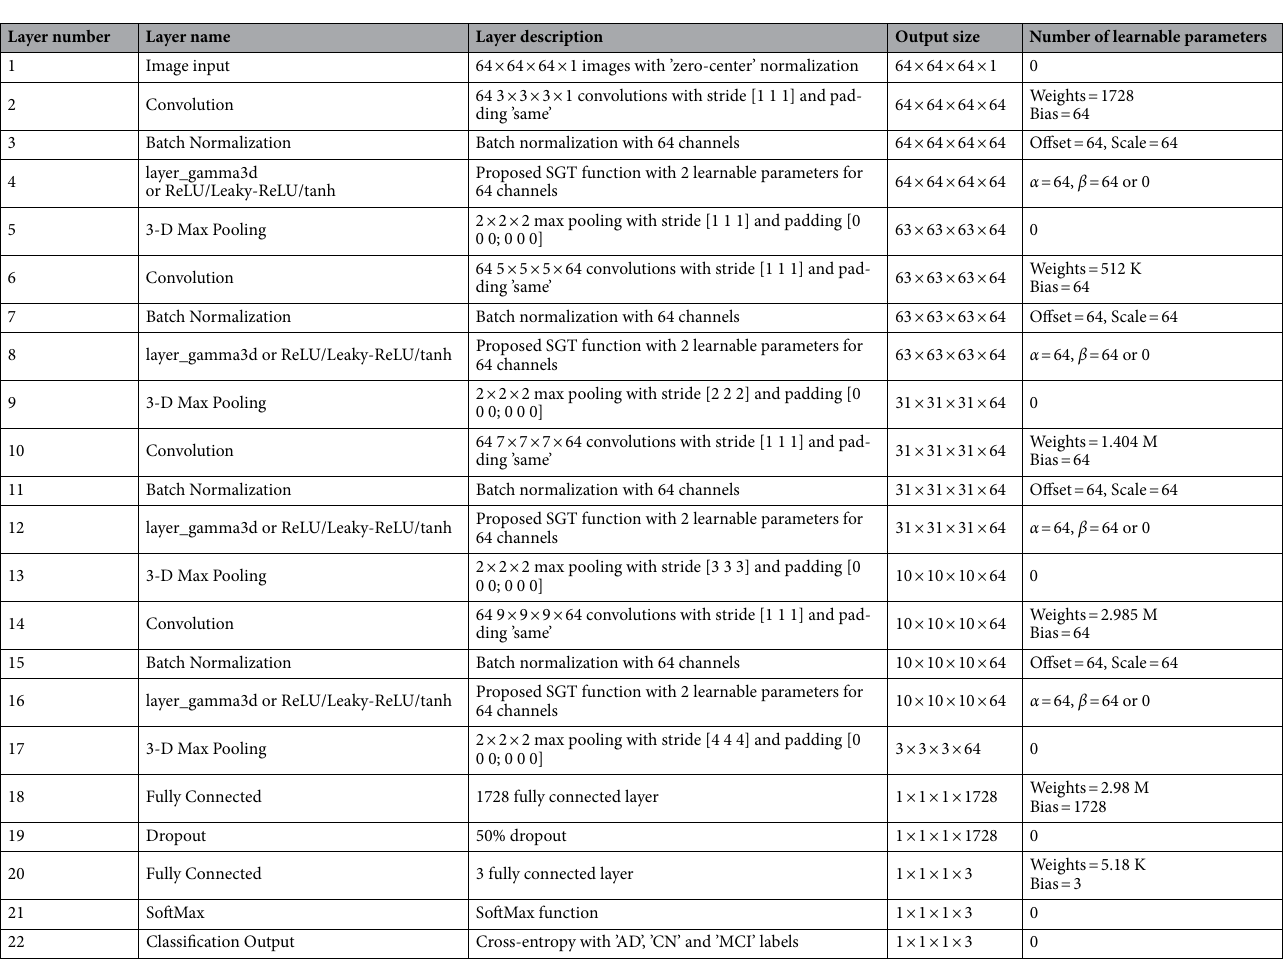
Table 2. CNN baseline architecture used to train and classify the MRI 3D scans. Here, while analyzing the performances of different activation functions, layers containing SGT functions i.e., layer_gamma3d are replaced with other existing standard activation functions. Weights and bias values for convolution and FCL were initialized using the ‘Glorot’ initialization technique and for the proposed SGT layer, α and β values were randomly initialized between 0 and 1. The initial learning rate was set at 0.001 with learn drop factor of 0.95 after every 10 epochs and fully trained up to 80 epochs.